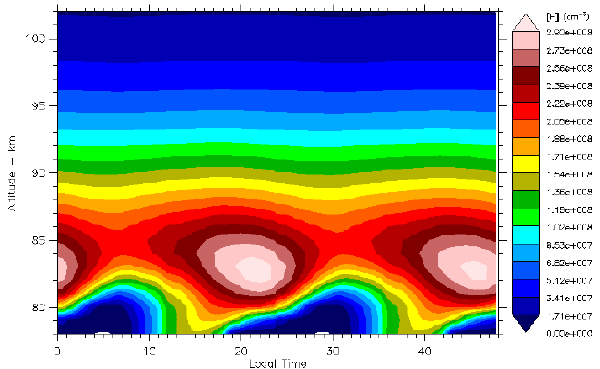
Fig. 3b. Local time variation of O for model days seven through eight in the equatorial region for August. The effects of the diurnal tides are again evident. Note the scale is 2.28 times smaller than in Fig. 3a. The maximum O densities are less than one-half those for April in Fig.